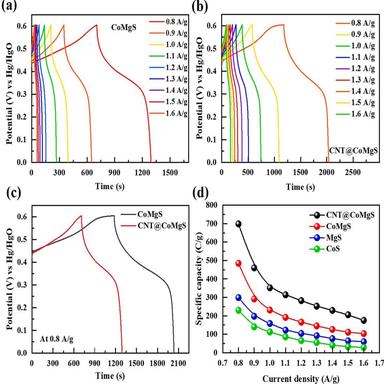
(a) GCD curves with potential window 0.6 V of CoMgS and (b) CNT@CoMgS, (c) At current density 0.6 A/g indicate the comparison of GCD plots. (d) Comparison of calculated Qs values.